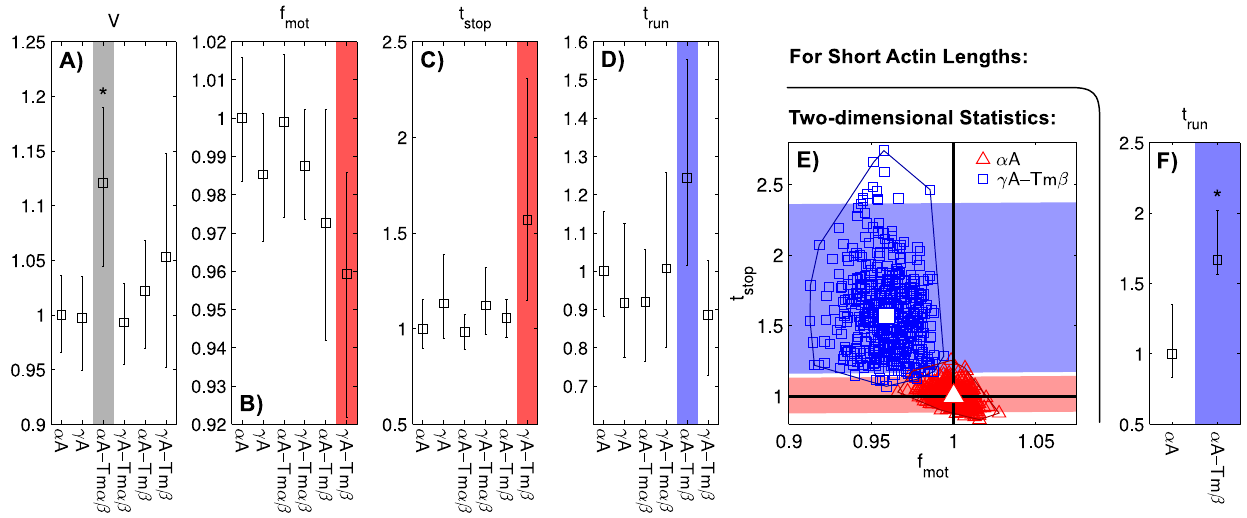
Figure 4. Fold changes in invitro motility features. All fold changes are relative to a A, averaged over L , error bars are 95% confidence intervals. A–D) Motility features averaged over whole L range. V is statistically significantly elevated for a A-Tm ab . E) Statistically significant differences for c A- Tm b become apparent by using 95% confidence bands in a two-dimensional space spanned by f mot and t stop (red and blue area, projection of bootstrap data points onto vector connecting both conditions). F) t run is statistically significantly elevated for a A-Tm b in the short L range. Windowing parameters as in Fig. 2, except for panel F: 0 : 325 { 1 : 0 m m , window width 0 : 1 m m , 25 windows.